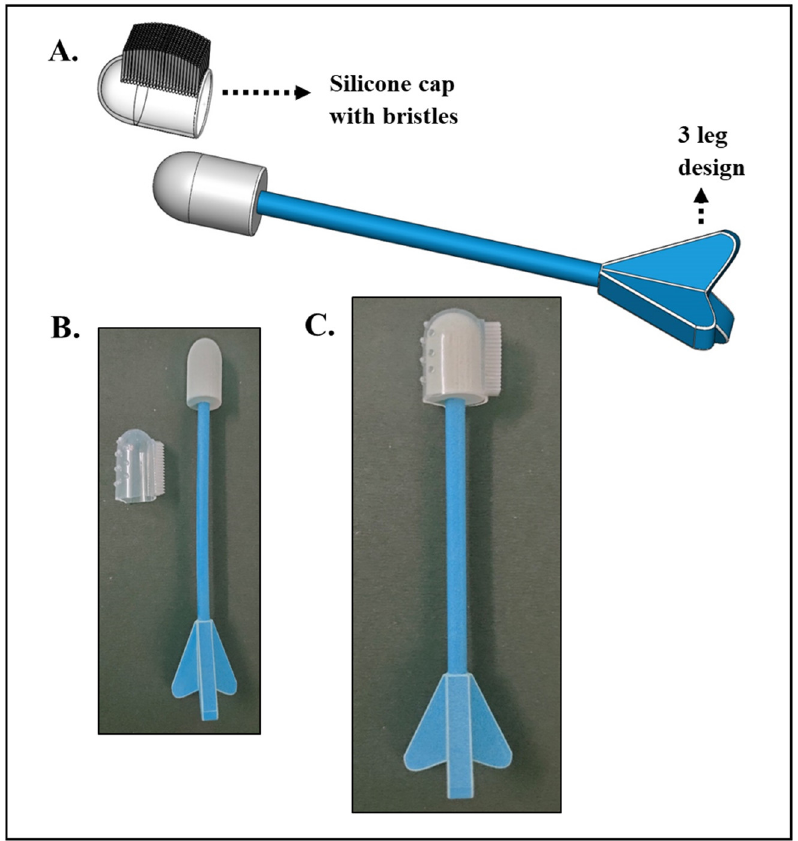
Figure 5. C ervi S elf design 1. ( A ) Design. ( B , C ) Prototypes of the design with silicone bristles.